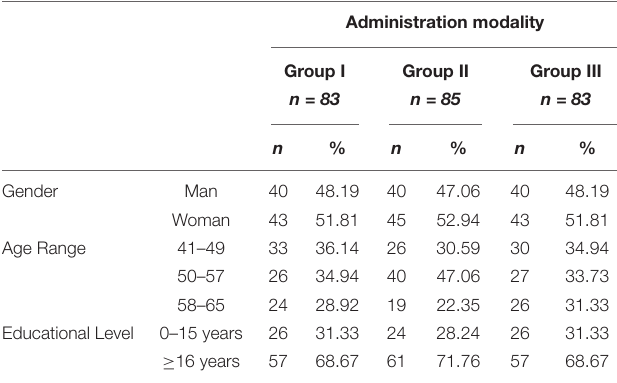
TABLE 11 | Demographic characteristics of the long-term forgetting (LTF) sample.